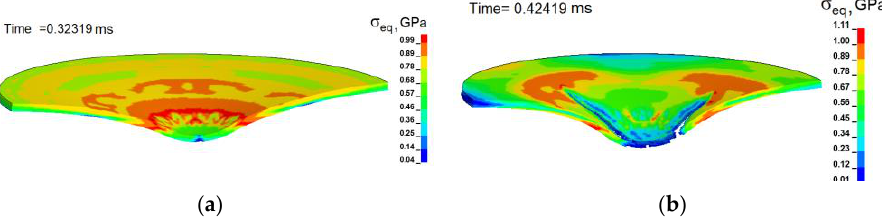
Figure 8. ( a ) Calculated distribution of equivalent stress in the cross-section of a punched Ti-5Al-2.5Sn plate at the time of 0.32319 ms and ( b ) at the time of 0.42419 ms. The velocity of the punch is 15 m/s.